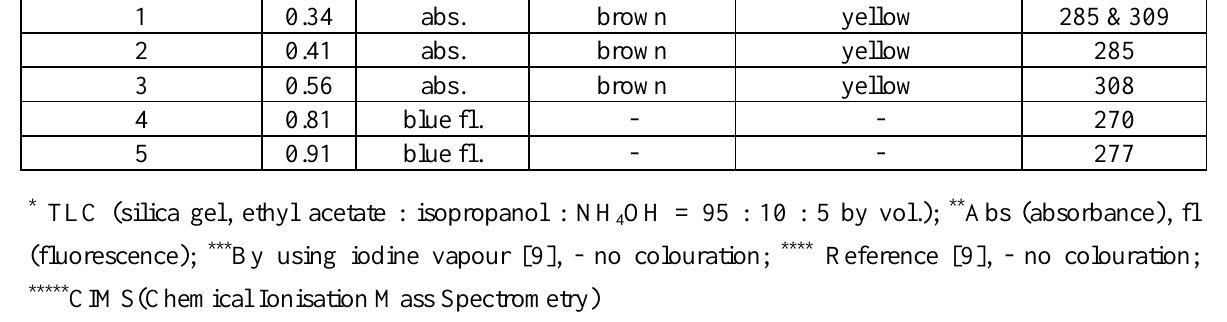
Table 3. Some characteristics of components in the crude alkaloidal extract of C. calamitosum L. Component